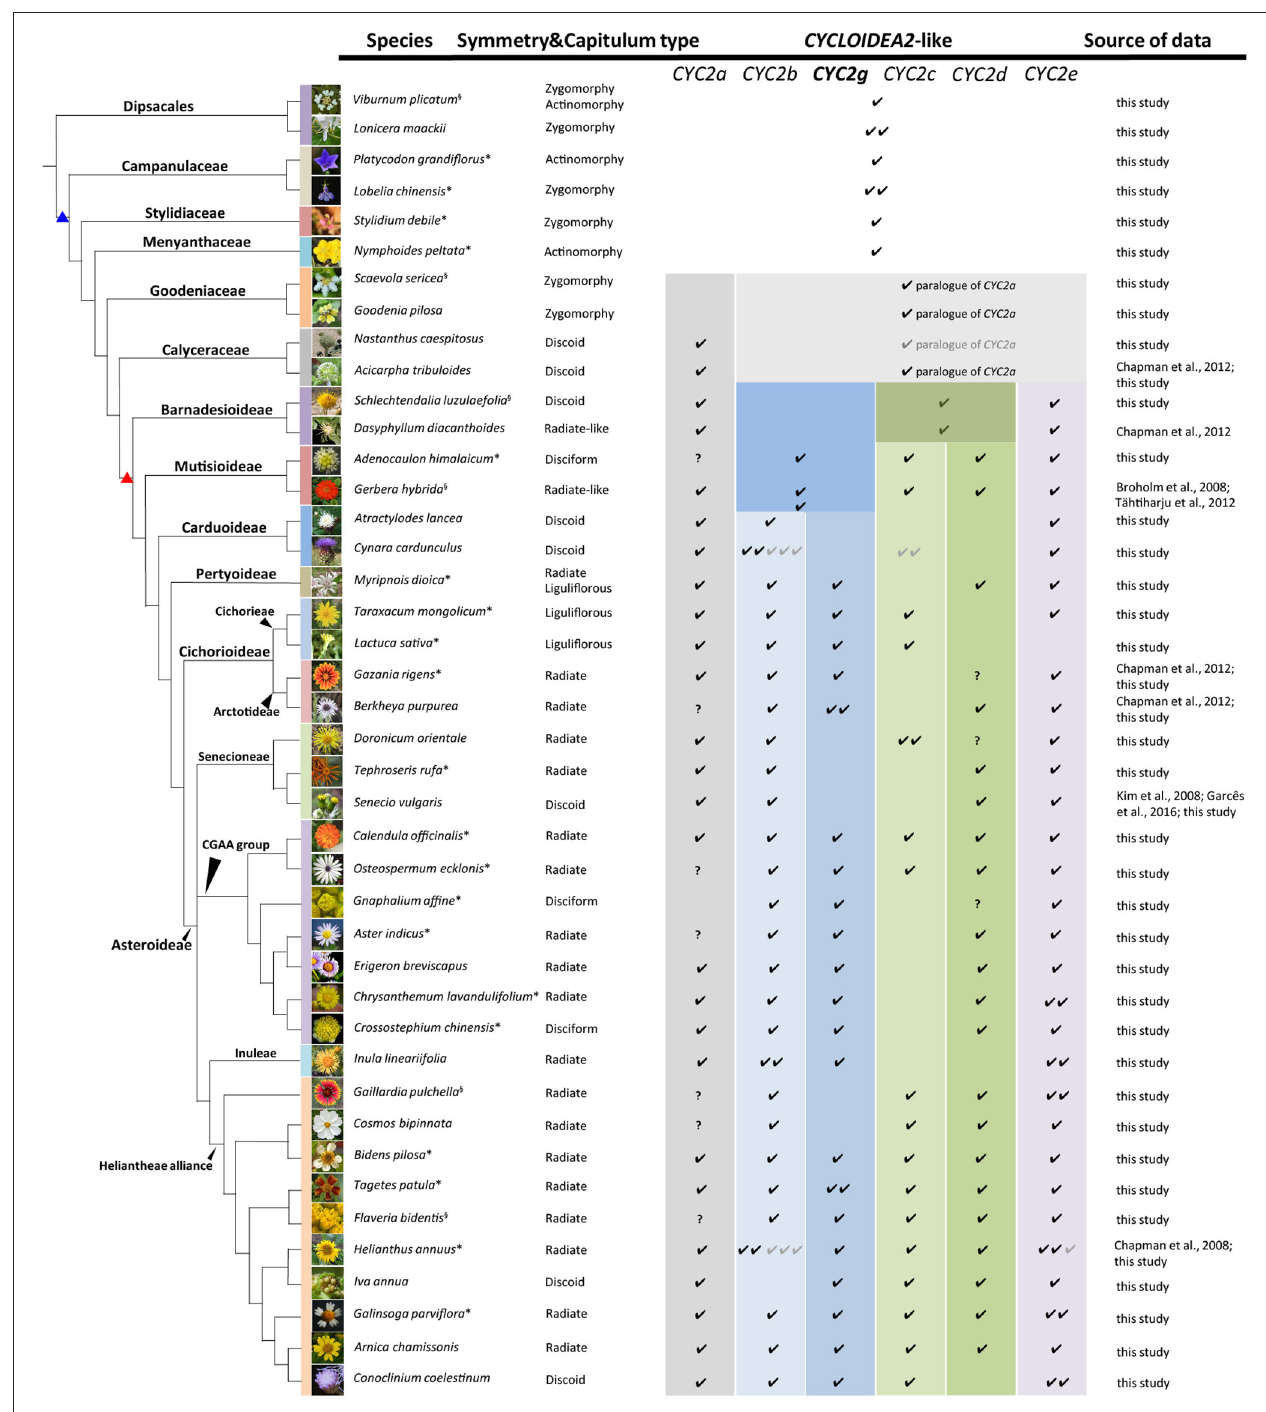
FIGURE 1 | Capitulum morphologies of the representative sampled species in this and previous studies. The species are listed according to the phylogenetic relationships reported by Panero and Funk (2008), Funk et al. (2009) and the APG IV (Chase et al., 2016). The branches marked with blue and red triangles stand for the Asterales and Asteraceae, respectively. The presence of each CYC2 -like gene in each species is marked by “ √ ,” the gray “ √ ” indicates a pseudogene, and “?” means the gene has not been isolated so far in this species but is proved to exist in other relatives of the same tribe. The CYC2g clade gene highlighted in bold letters is newly identified and named in this study. The superscript on the top right of each species name denotes the source of the flora image: * stands for photographs taken by the present authors, “§” stands for photos from Wikipedia (https://www.wikipedia.org/), and the rest are from several open websites: Lonicera maackii